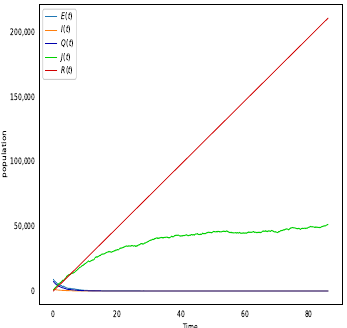
Figure 4. The solution of system (2) when ε + λ > β ∗ k + α 2 equilibrium P 0 is